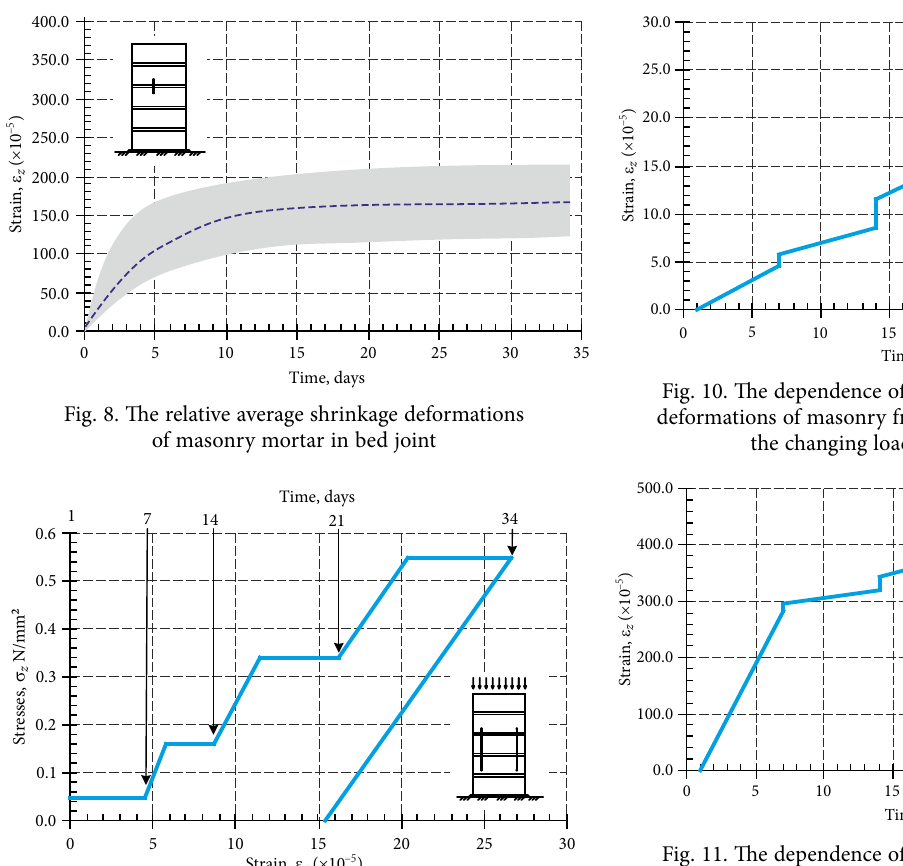
Fig. 9. The relative longitudinal plastic deformations of masonry fragment compressed with the changing load over the time